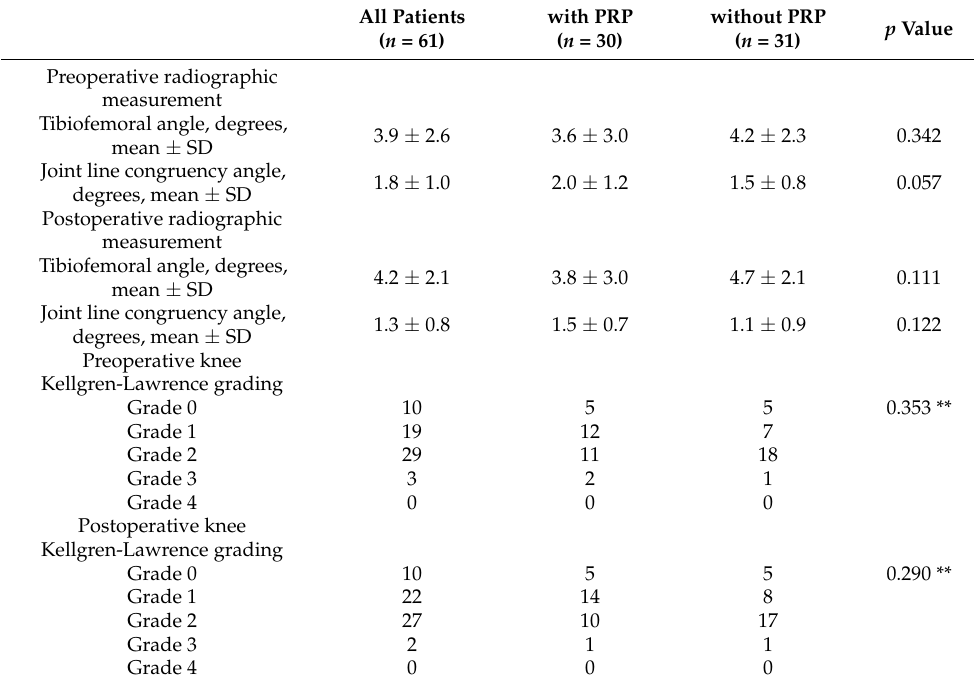
Table 3. Comparison of radiographic